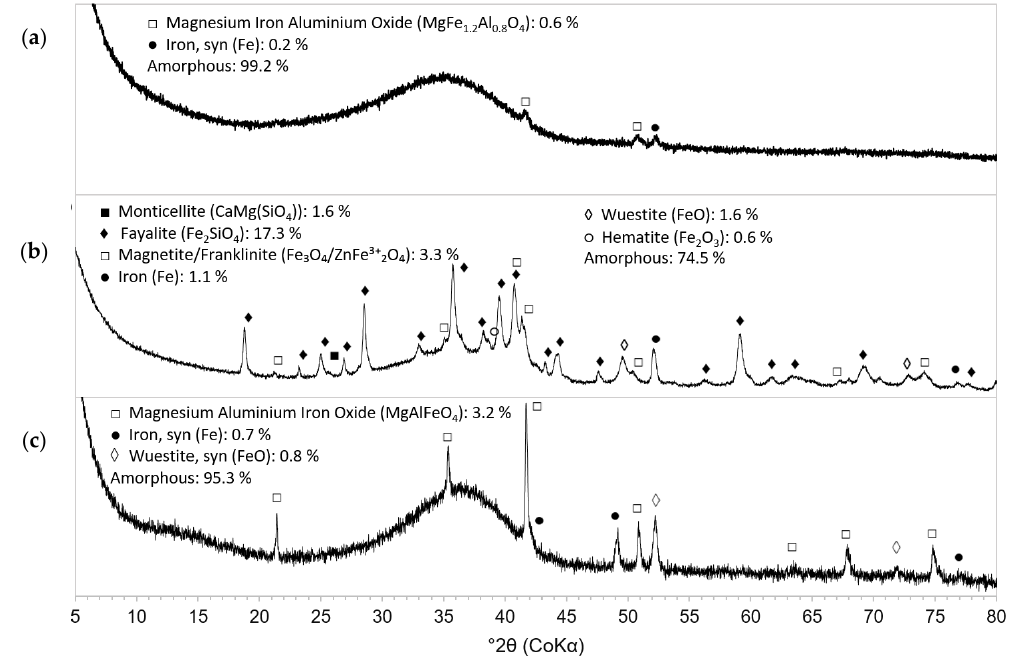
Figure 1. XRD patterns and phase quantification results of the treated slags: ( a ) TS1, ( b ) TS2 and ( c ) TS3. Rietveld analysis was performed using HighScore Plus software (version 4.6a), and the external standard approach was used to determine the amorphous phase content (rutile; Kronos 2300 TiO 2 external standard calibrated against NIST SRM 676a α -Al 2 O 3 ). The